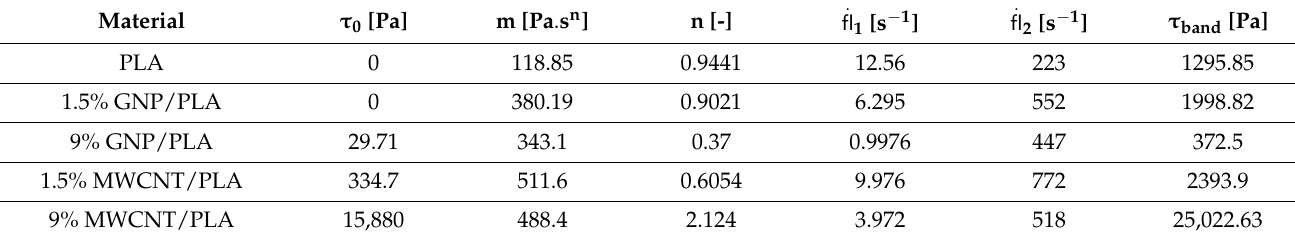
Table 2. Rheological and banding properties.